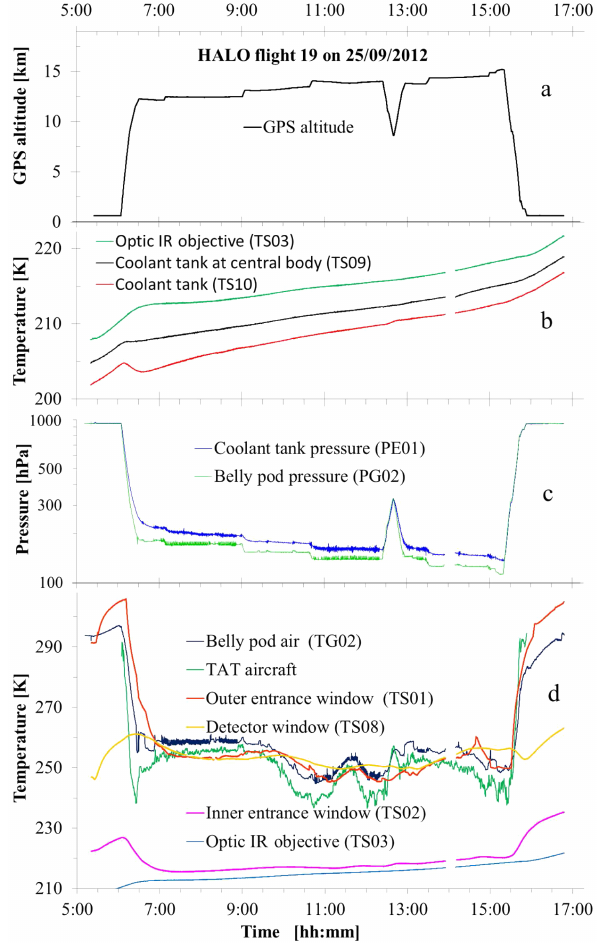
Figure 15. Conditions observed during flight 19 on HALO. The plots show (a) flight altitude, (b) optic and coolant tank tempera- tures, (c) coolant tank pressure, (d) aircraft and window tempera-